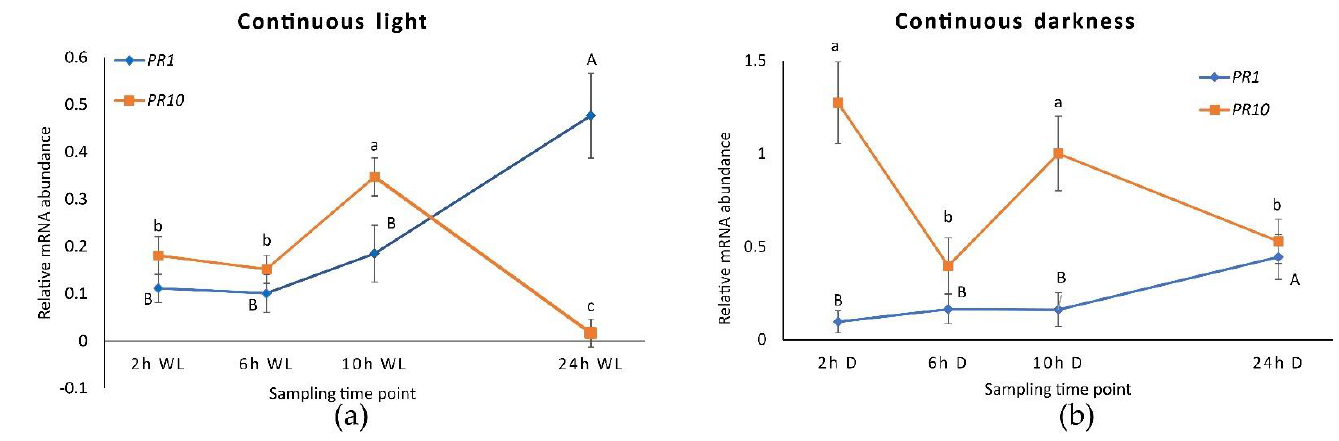
Figure 5. PR1 and PR10 expression in Dar Gazi-wt plantlets: ( a ) in 24 h continuous light (WL); ( b ) in 24 h continuous darkness. The results are presented after normalization with ef1A . Data shown as the average of two biological replicates run in triplicate, with error bars representing SD. For each single gene expression pattern, values with different letters significantly differ according to the analysis of variance (ANOVA) and least significant difference (LSD) tests ( p ≤ 0.05). Uppercase and lowercase letters are referred to as PR1 and PR10 , respectively.